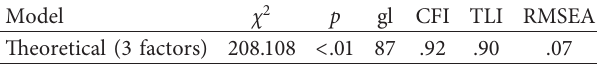
Table 3: Indices of the model’s goodness of fit.